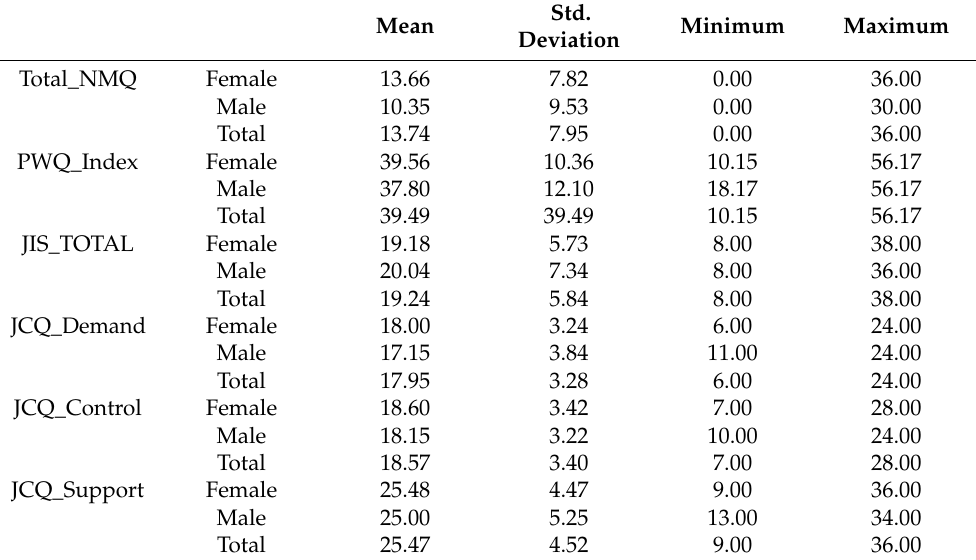
Table 2. Descriptive